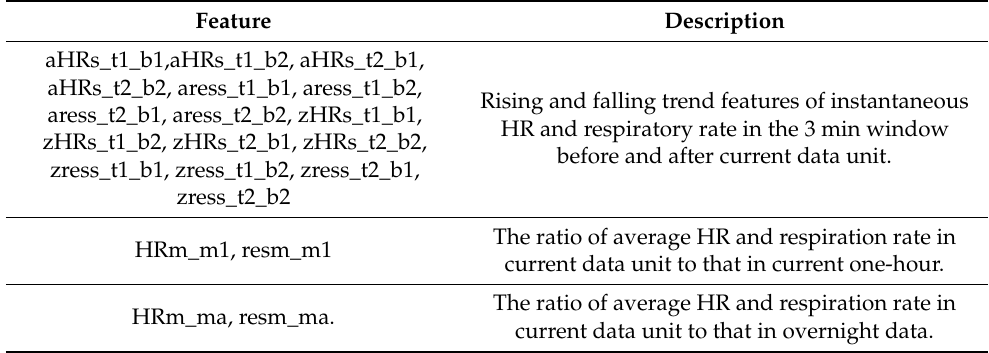
Table 2. Candidate features that represent the relationship between current data unit and the adjacent/overnight data units.